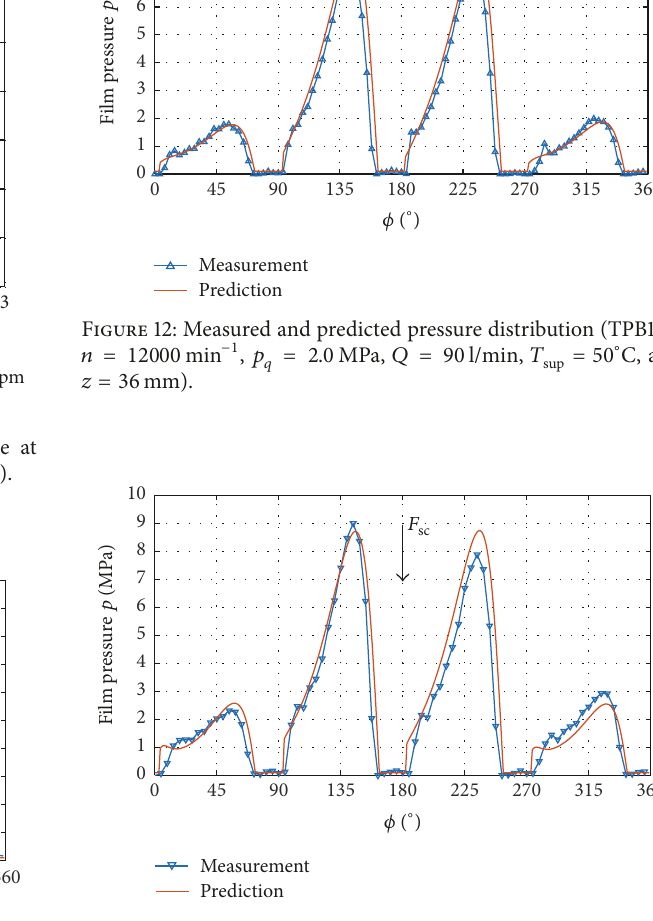
Figure 13: Measured and predicted pressure distribution (TPB120, 𝑛 = 15000 min −1 , 𝑝 = 2.0 MPa, 𝑄 = 90 l/min, 𝑇 𝑞 𝑧 = 36 ∘ C, and sup = 50